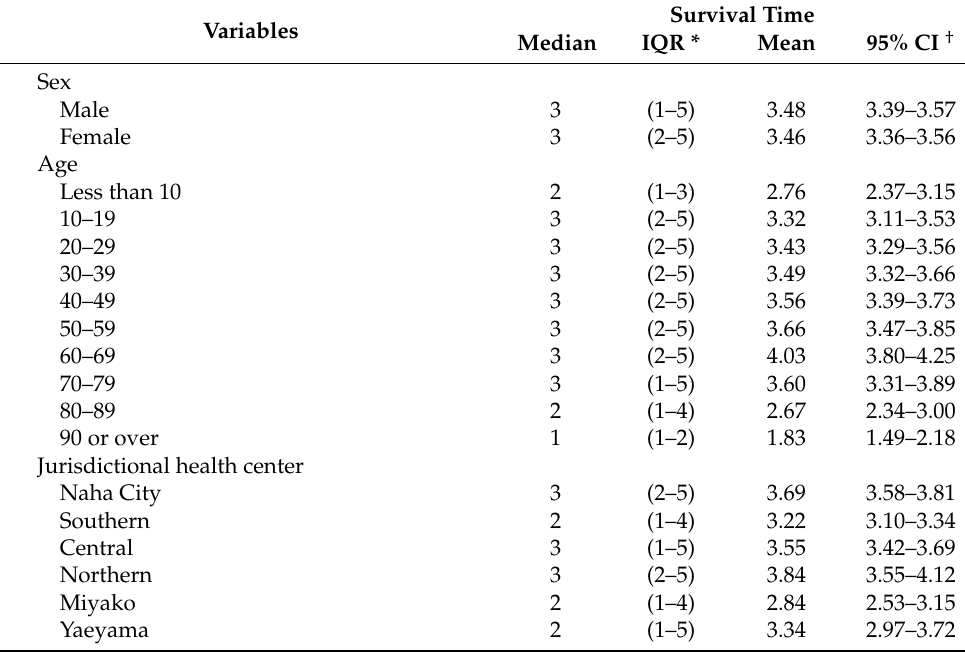
Table 2. The number of days from symptom onset to diagnosis for each